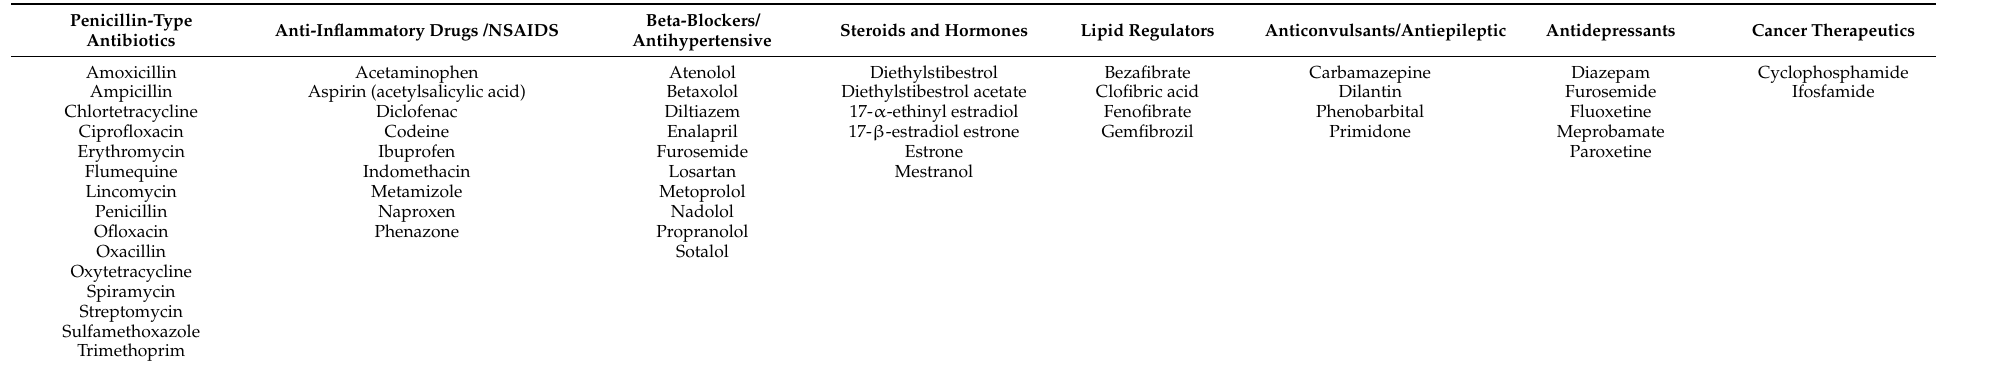
Table 2. Pharmaceuticals commonly found in the aquatic environment